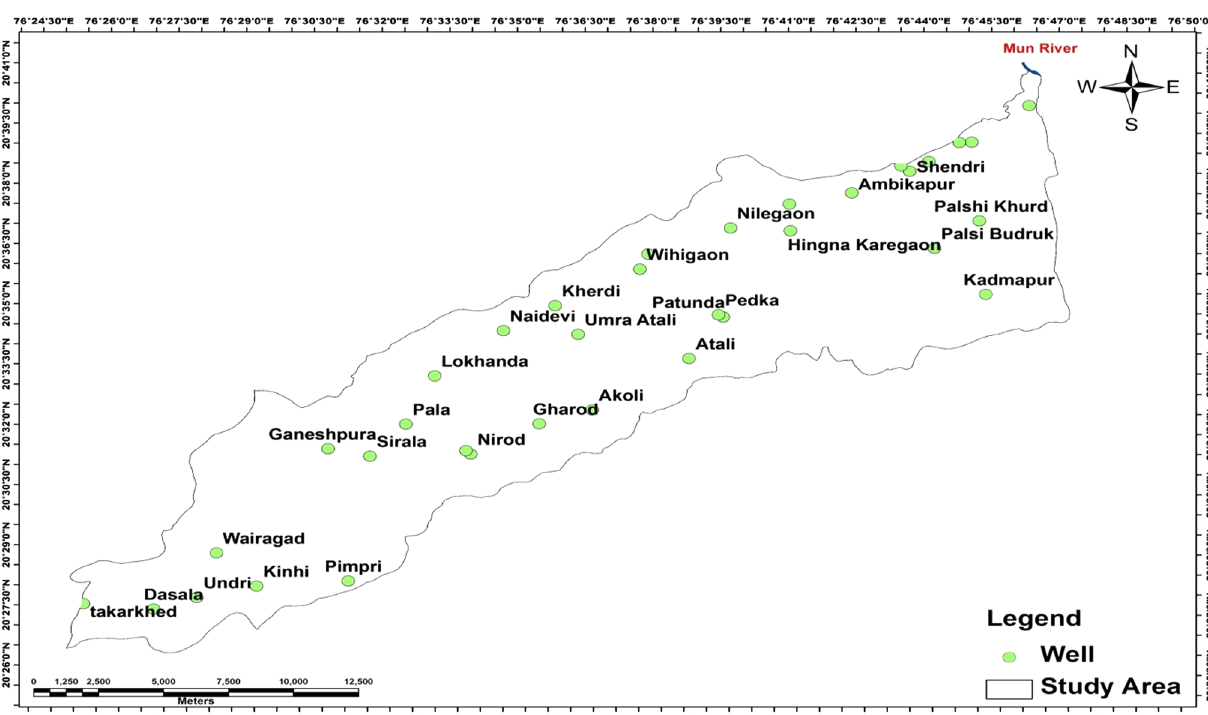
Fig. 2 Well location map of Basaltic hard